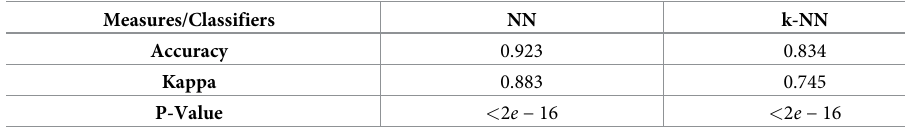
Table 5. Experimental results using both classifiers for the testing